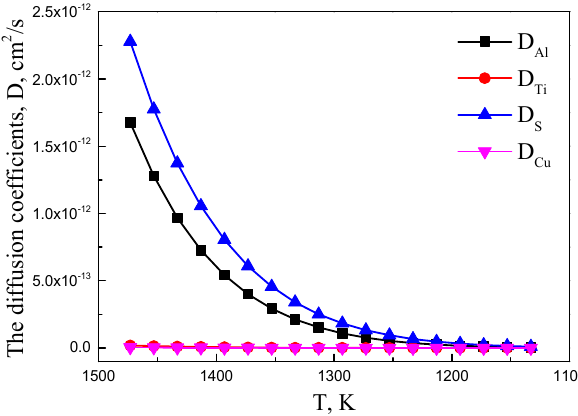
Figure 10. Variation of the diffusion coefficients of control elements with temperature.